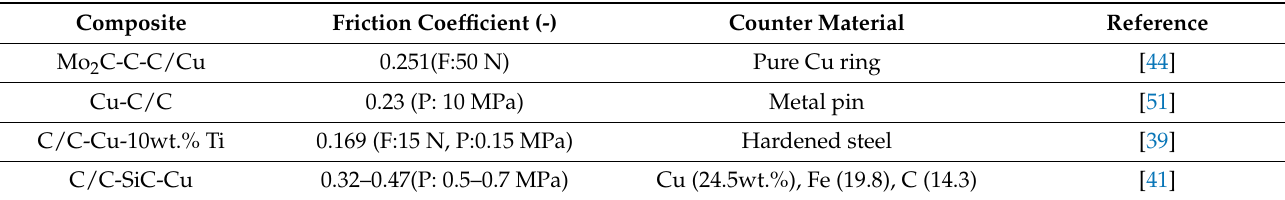
Table 4. Friction coefficient of infiltrated composites.